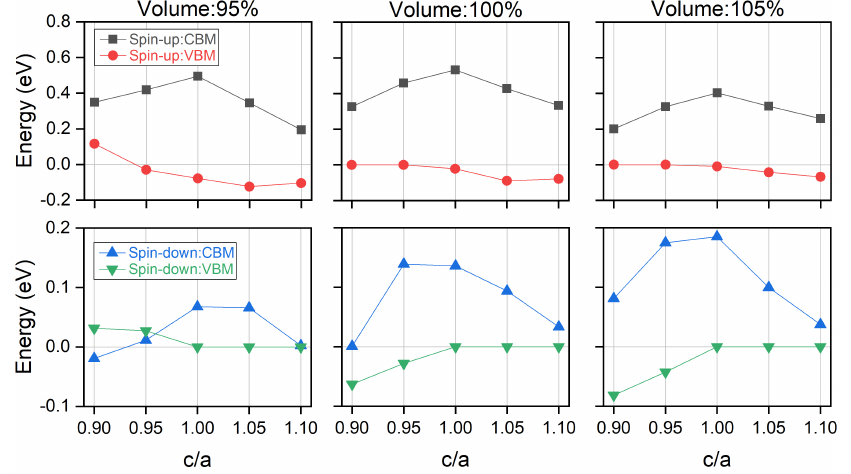
Figure 7. The conduction band minimum (CBM) and valence band maximum (VBM) in spin-up and spin-down directions of Ti 2 MnAl compound with different unit cell volume under tetragonal deformation of different c/a ratio. Please note that the vertical axis has different scales in the two spin directions.